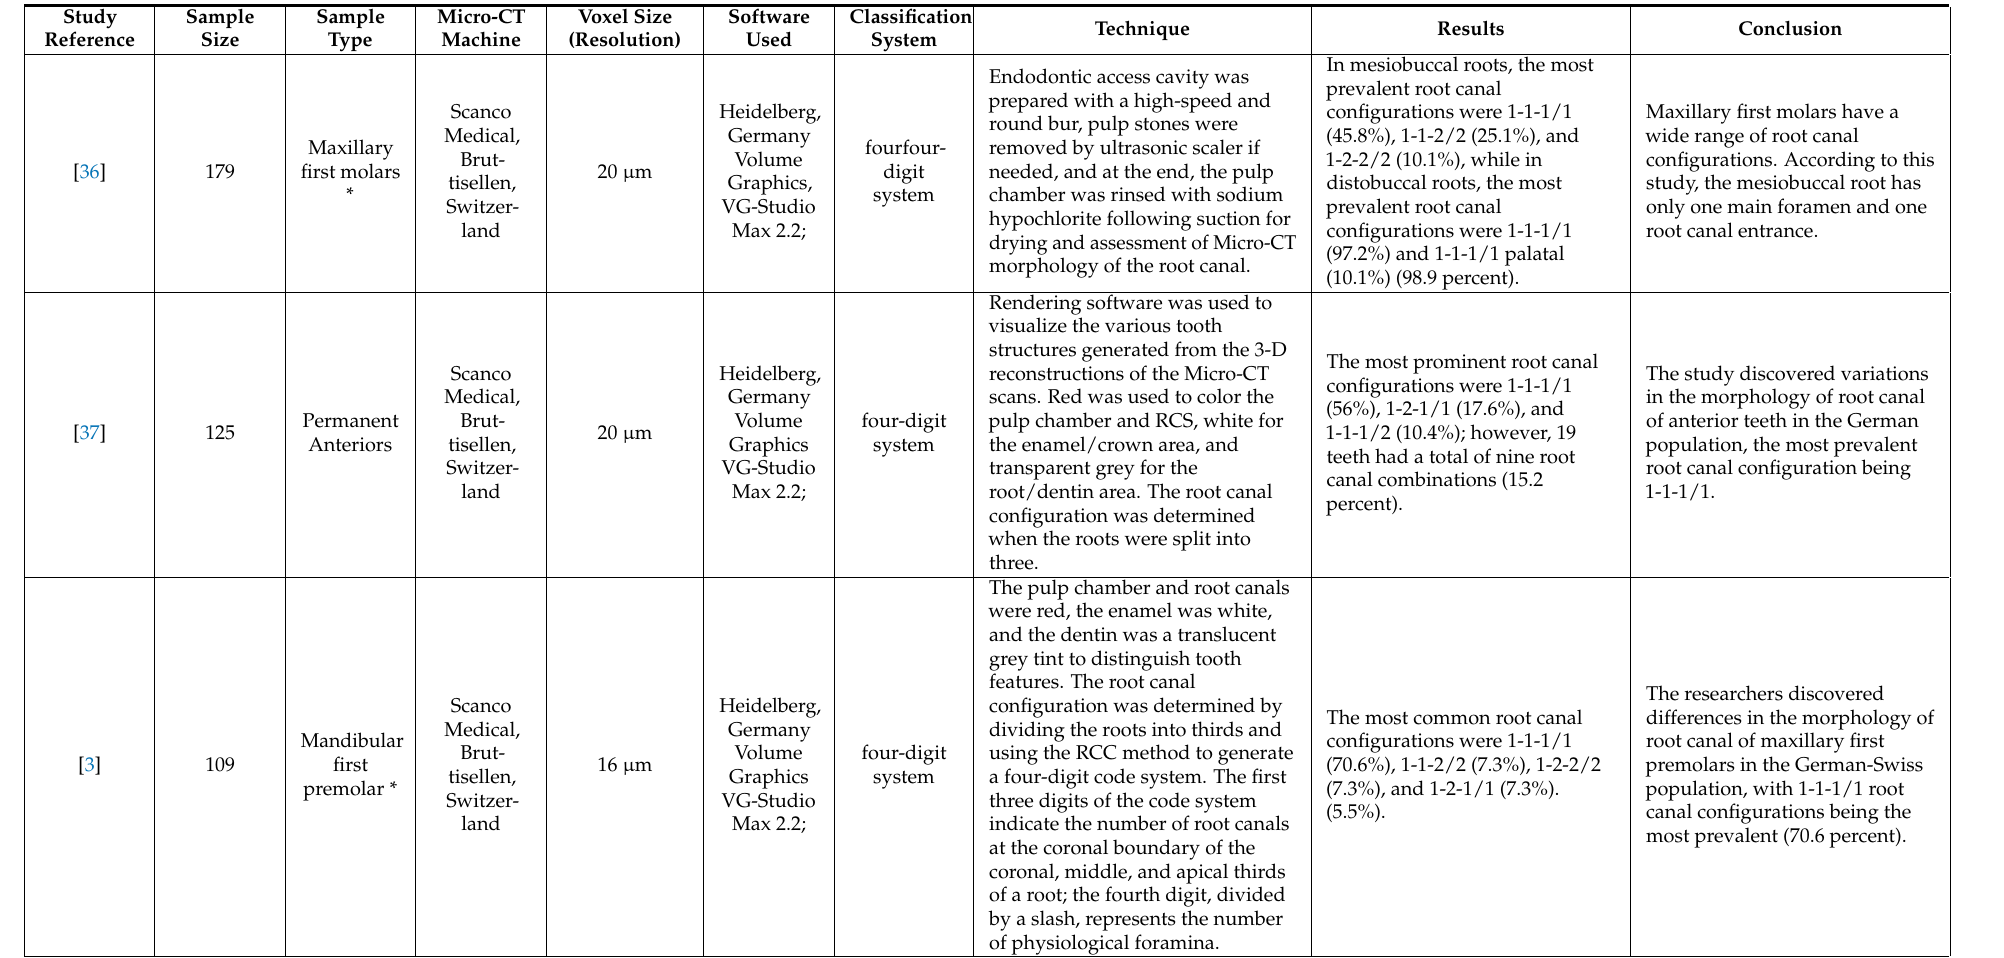
Table 3. Characteristics of the included